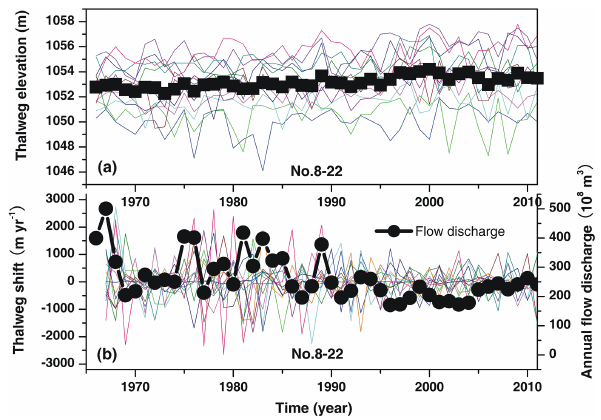
Figure 8. Lateral channel shifts (b) and the rising thalweg beds (a) monitored from 1965 to